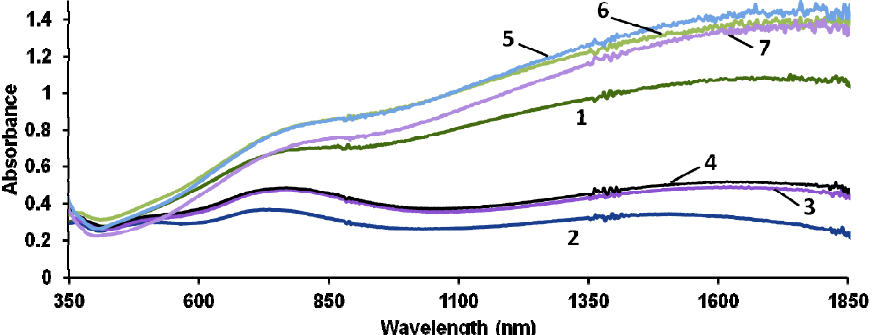
Figure 5. Electronic UV–Vis–NIR absorption spectra of films of PEDOT complexes with PAMPSA (1), t-PASA (2), PAMPSA/t-PASA (1:1) (3), PAMPSA/t-PASA (2:1) (4), PAMPSNa (5), t-PASNa (6) and PAMPSNa/t-PASNa (7) obtained during GS synthesis.